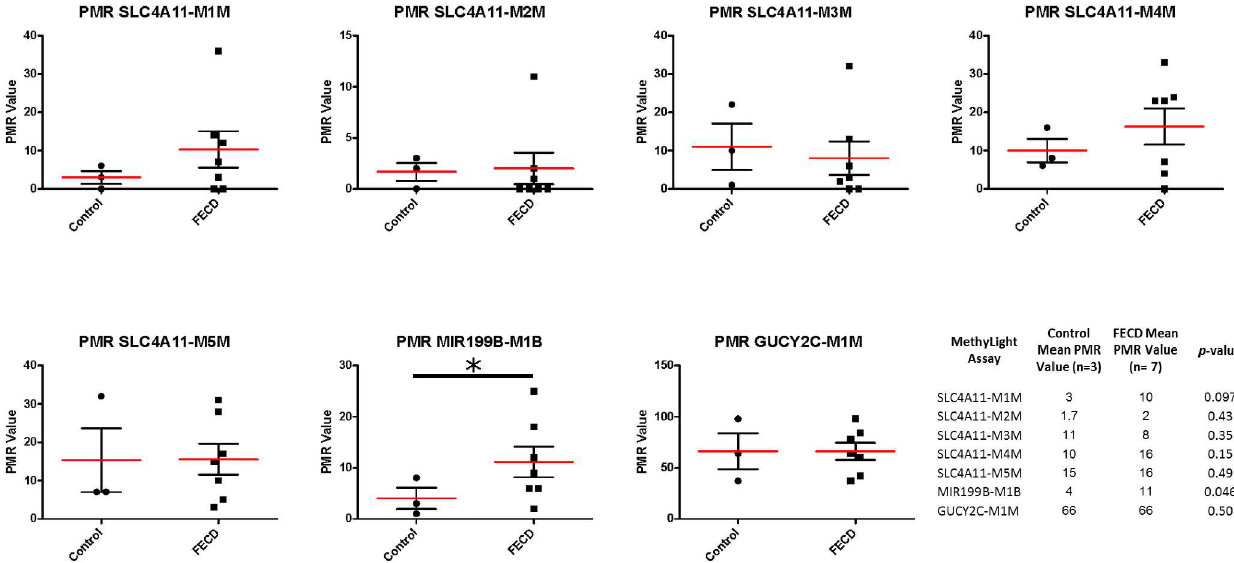
Fig 6. MethyLight analysis for SLC4A11 , MIR199B , and GUCY2C in FECD and control endothelial tissues. Quantitative DNA methylation- sensitive real-time polymerase chain reaction (MethyLight) analysesperformed on samples from three control samples and seven FECD samples. MethyLightdata are presented as percent of methylatedreference (PMR). The table lists the mean PMR values for the control and FECD samples and p-values for each MethyLight assay.